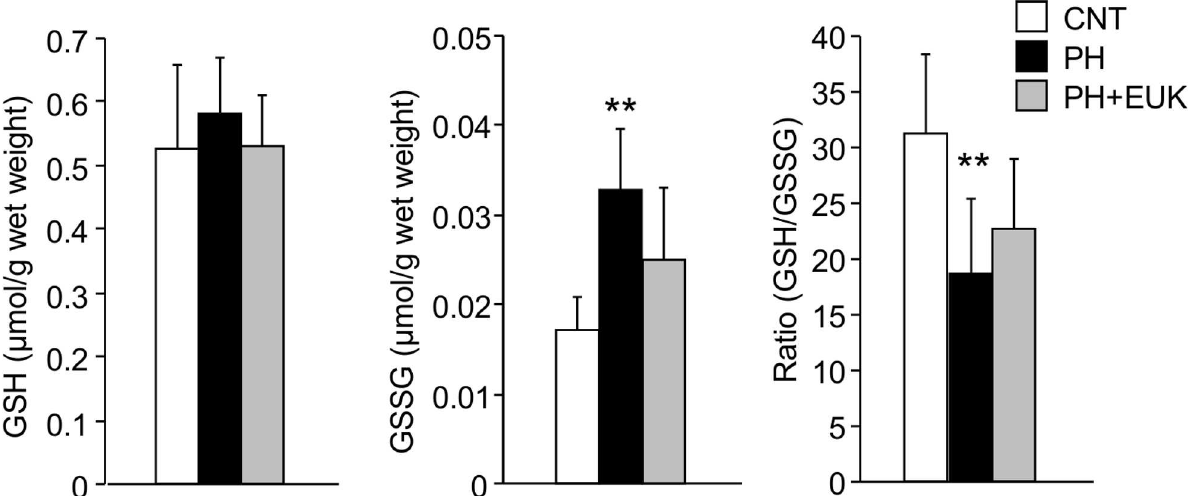
Fig 4. GSH: GSSG ratio is decreasedin diaphragm muscles from PH rat. The cytoplasm levels of GSH, GSSG, and the GSH: GSSG ratio in diaphragmmuscles from CNT and PH rats with or without EUK-134 (EUK) treatment. Data show mean ± SD for 5–8 rats in each group. ** P < 0.01 vs .